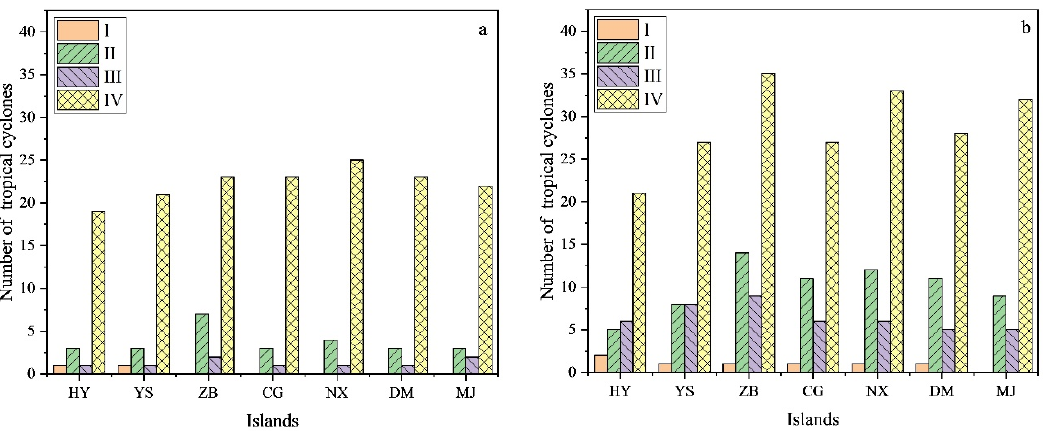
Figure 11. Numbers of TCs in four track patterns. ( a ) 500 km radius; ( b ) 800 km radius.